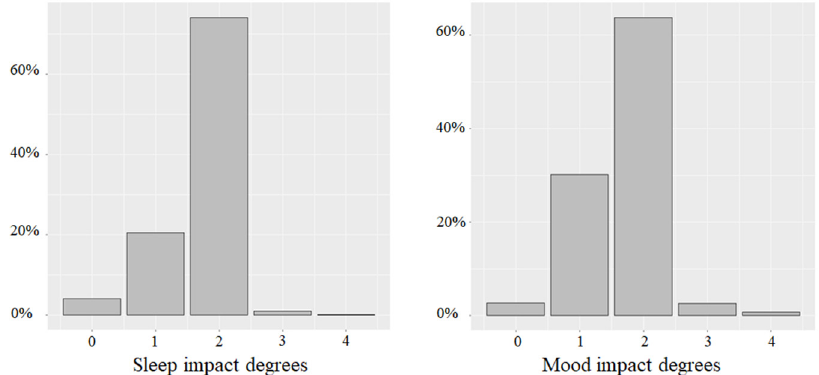
Figure 3. Distribution of impacts on sleep quality and mood impact. Note: 0 = “Considerably deteriorated”, 1 = “Deteriorated”, 2 = “No impact”, 3 = “Improved” and 4 = “Considerably improved”.